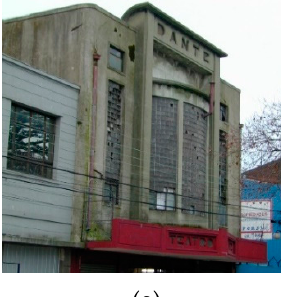
Table 14. Summary of the seismic vulnerability assessment (SVA) result.